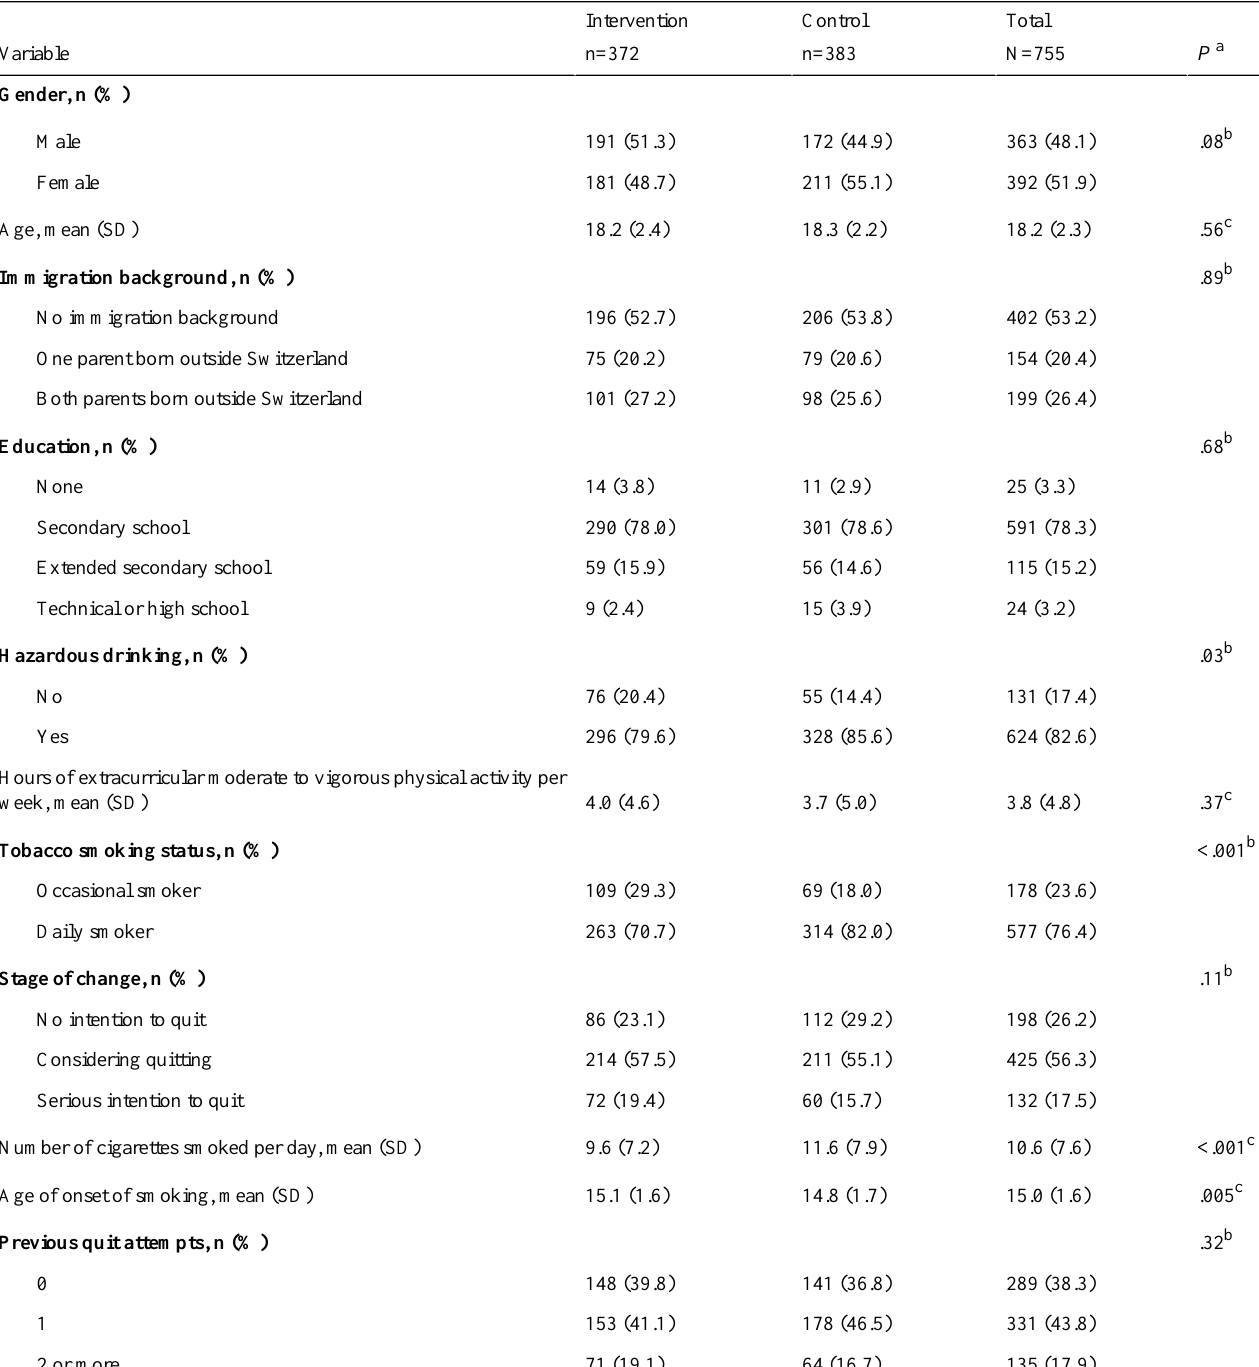
Table 1. Demographics and health- and smoking-related baseline characteristics of the study